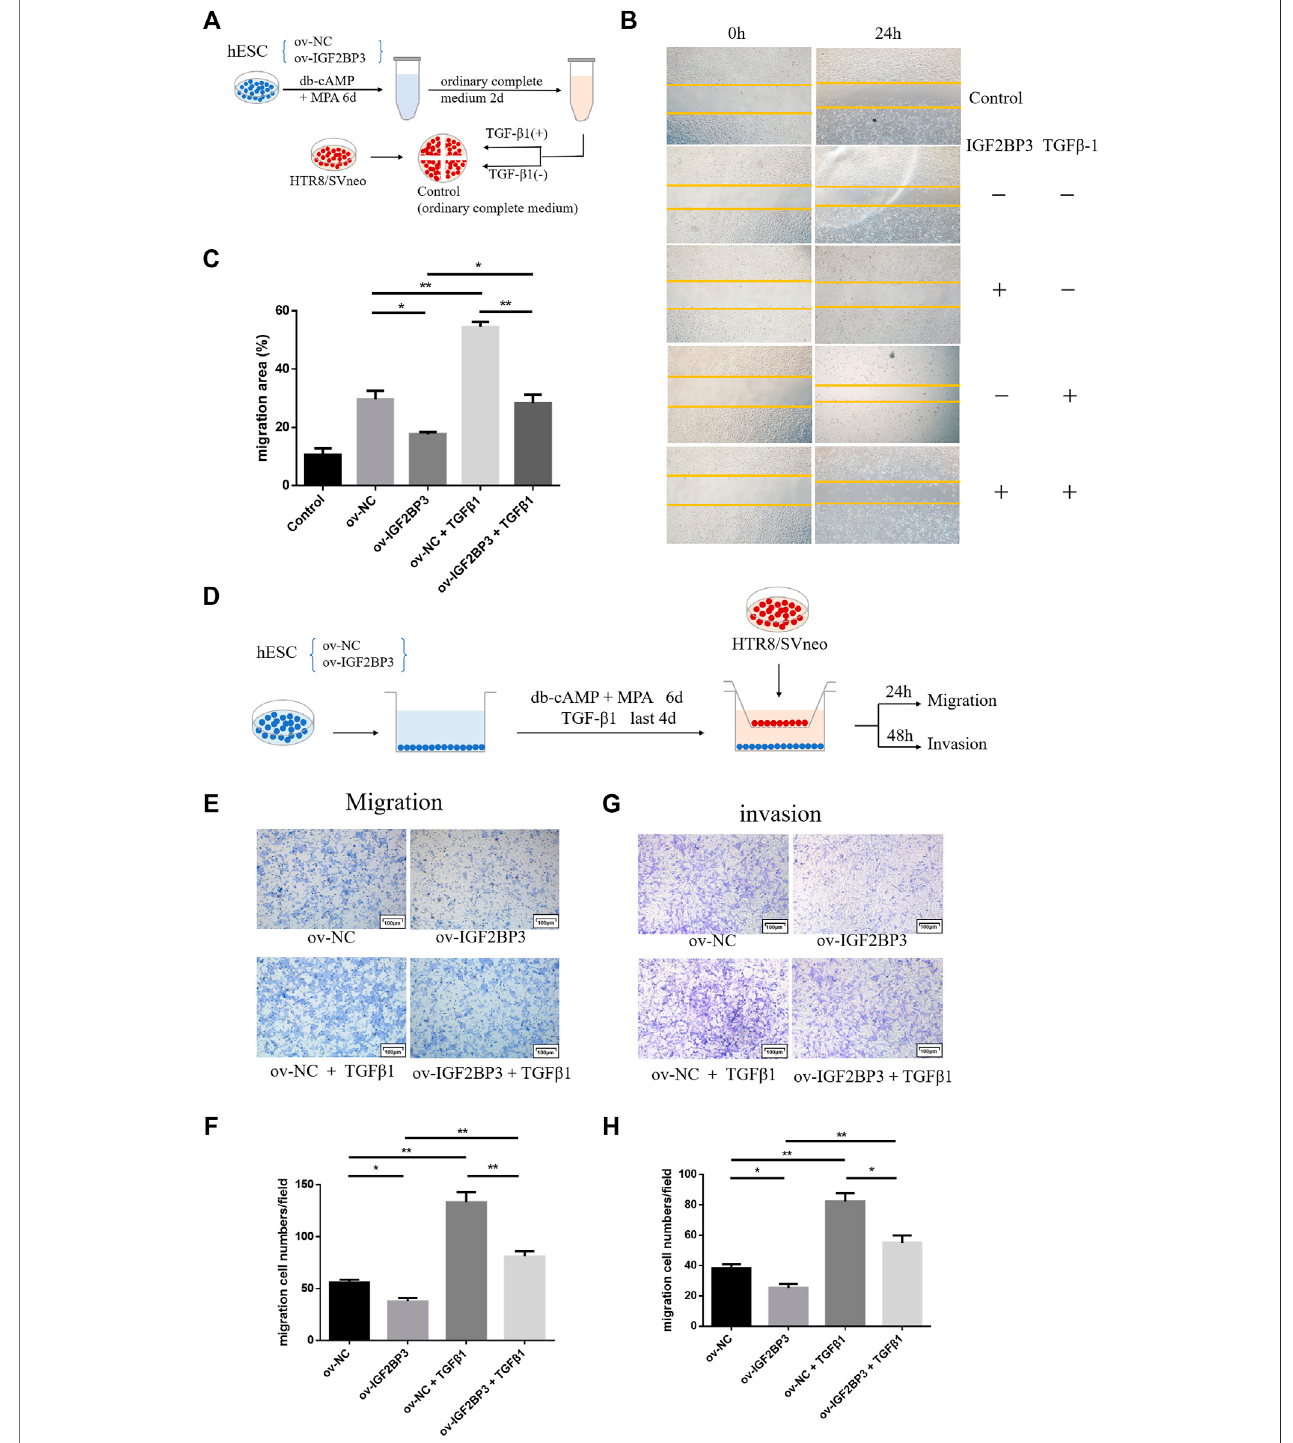
FIGURE 5 | IGF2BP3 and TGF- β 1 in the maternal – fetal interface cells cross talk (A) schematic diagram of the process of scratch wound-healing, (B) trophoblast cells were cultured for wound scratch assays using ov-IGF2BP3 and control decidual cells culture supernatants with selective TGF- β 1 addition, (C) HTR8/SVneo cells migrationquanti fi edbywound-healingindex.Migrationarea(%)=(A0 — An)/A0×100, (D) schematicdiagramoftheprocessofco-cultureandrescueexperiments, (E,F) transwellmigrationandinvasionofHTR8/SVneocellsco-culturedwithIGF2BP3-transfectedhESCssupplementedwithTGF- β 1,and (G,H) quanti fi cationstatistics of the results of cell migration and invasion. Each experiment was independently performed three times. * p < 0.05, ** p < 0.01, and *** p < 0.001 vs. control.